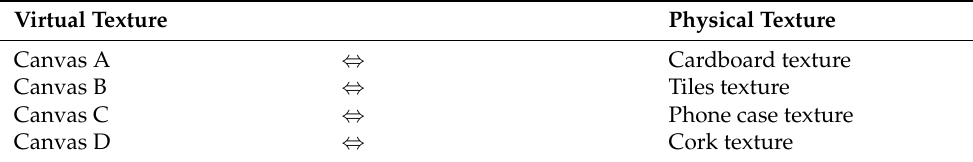
Table 1. Correct correspondence between virtual and physical textures for test